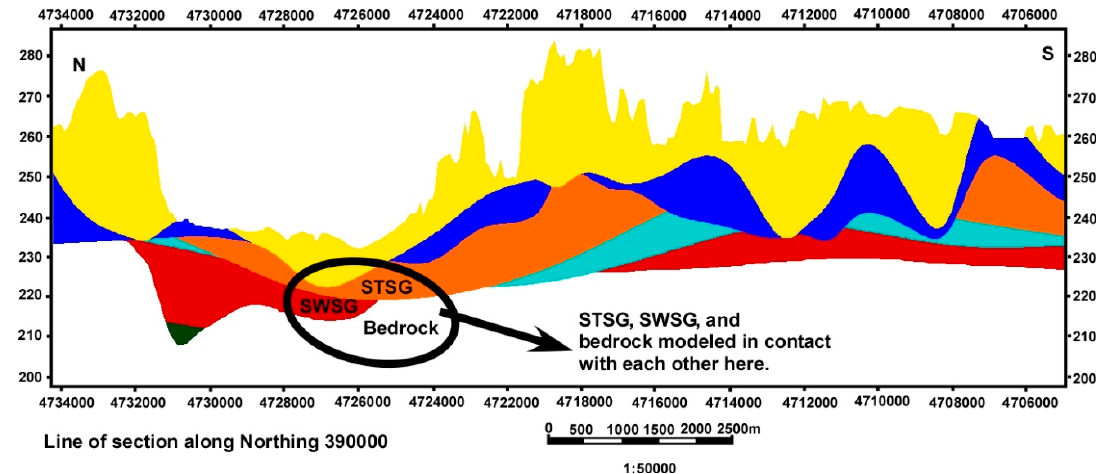
Figure 14. North–south line of section showing the STSG, SWSG, and bedrock in contact with each other. The x-axis is UTM coordinates in the vertical direction and the y-axis is the elevation above mean seal level in meters.